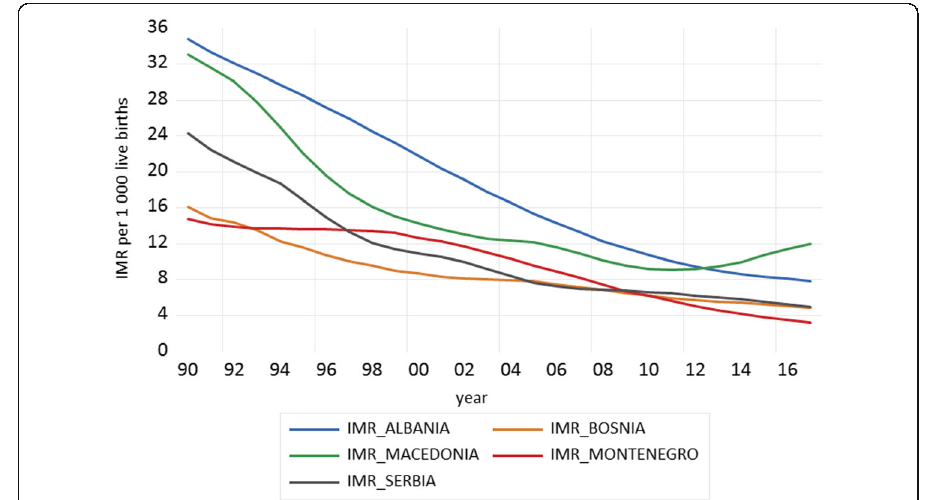
Fig. 2 Infant mortality rate in EU accession candidate countries: 1990 – 2017: Infant mortality rate per 1 000 live births in the EU accession candidate countries 1990 – 2017. Source: World Bank Group data. Author ’ s design based on EViews 11 software using annual time series data from Albania, Macedonia, Serbia,